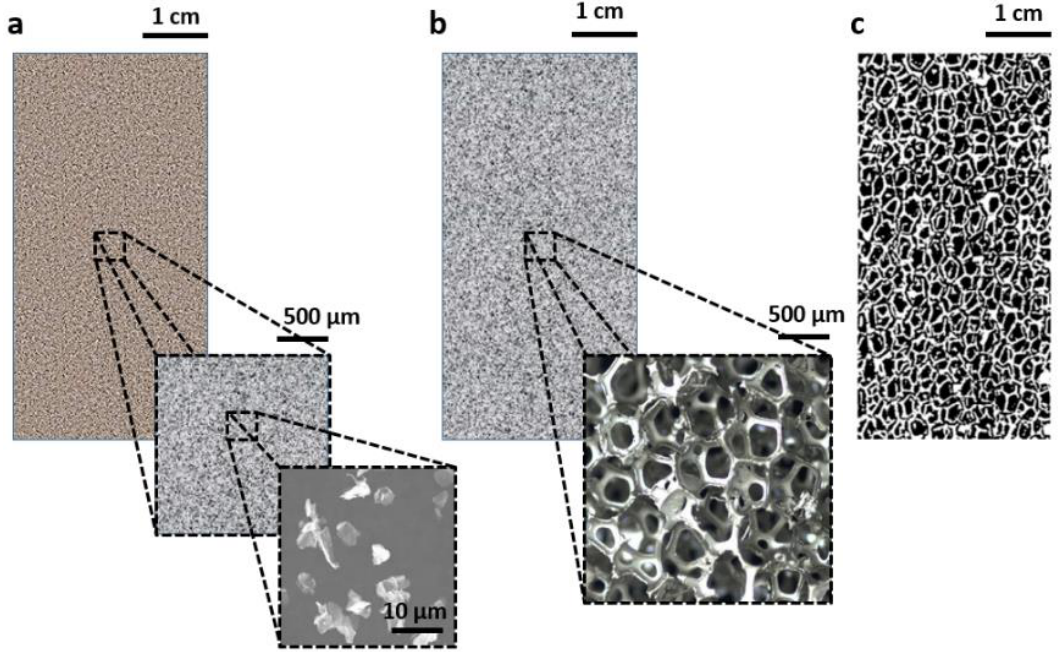
Figure 1. Representative length-scale of C-PCM materials related to the arrangement of the passive phases. Length scale of some tens of micrometer ( a ), of tenths of millimeter ( b ) and of some millimeter ( c ). Foam images in (b) and (c) adapted from [15], reprinted by permission from Springer Nature.